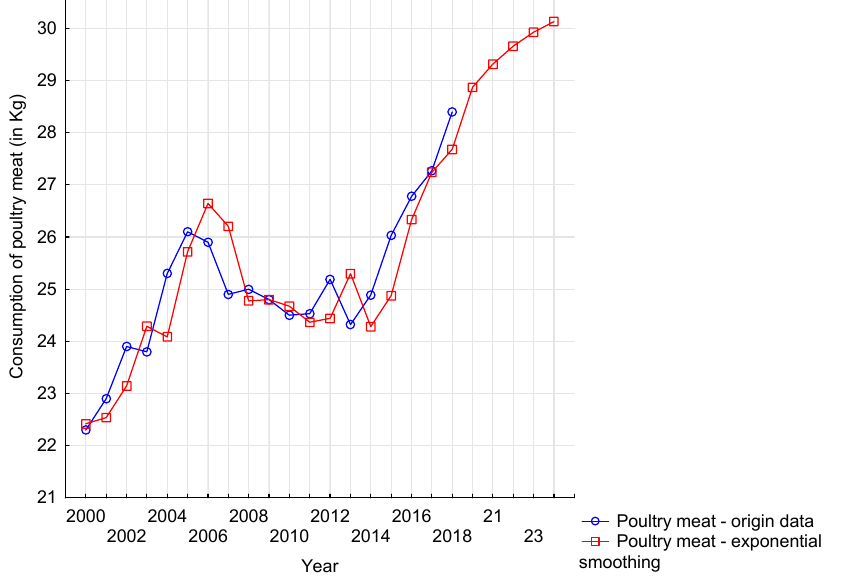
Figure 17. Prediction of poultry meat consumption in the Czech Republic until 2024 [27].